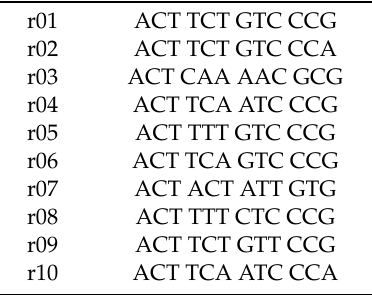
Table 3. Summary of repeat type sequences identified on the cell surface protein